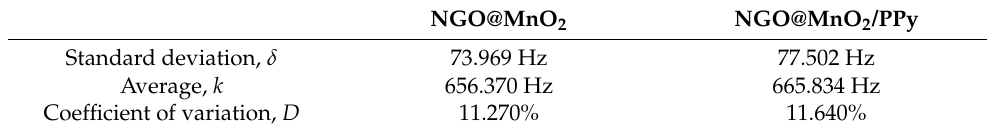
Table 4. The calculated values of δ , k , and D